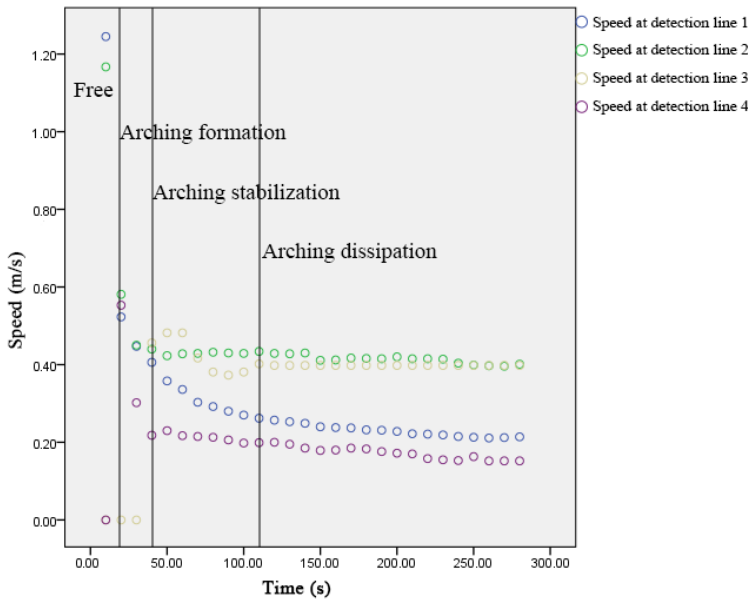
Figure 6. Speed scatterplot for different detection position.